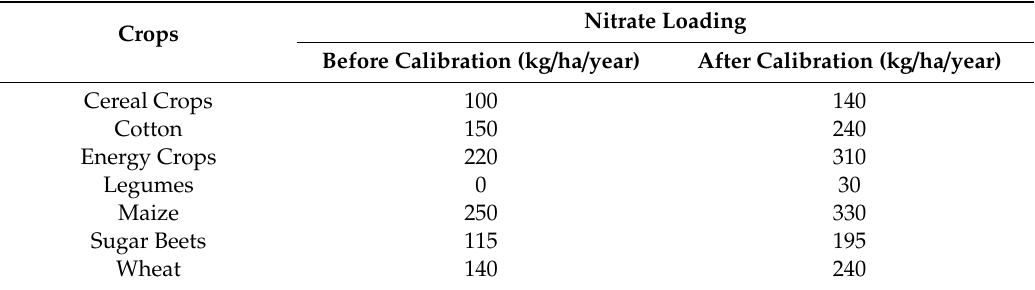
Figure 5. Scatter diagram of observed versus simulated nitrate concentration values for the study area on 1 September 2007. The equation of the linear regression and the R 2 value are also presented. Table 2. Parameters and changes before-and-after calibration of the main crops.